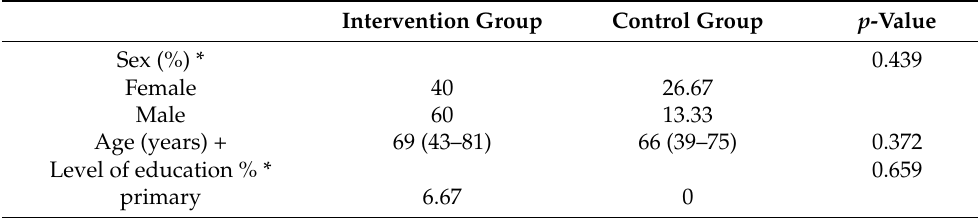
Table 1. Baseline group